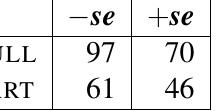
Table 3. Percentage of ‘true’ responses for Spanish test items with (a) all verbs and (b) the consumption verb comer (compared to ‘true’ responses for eat in English) − se + se comer FULL 97 70 FULL PART 61 46